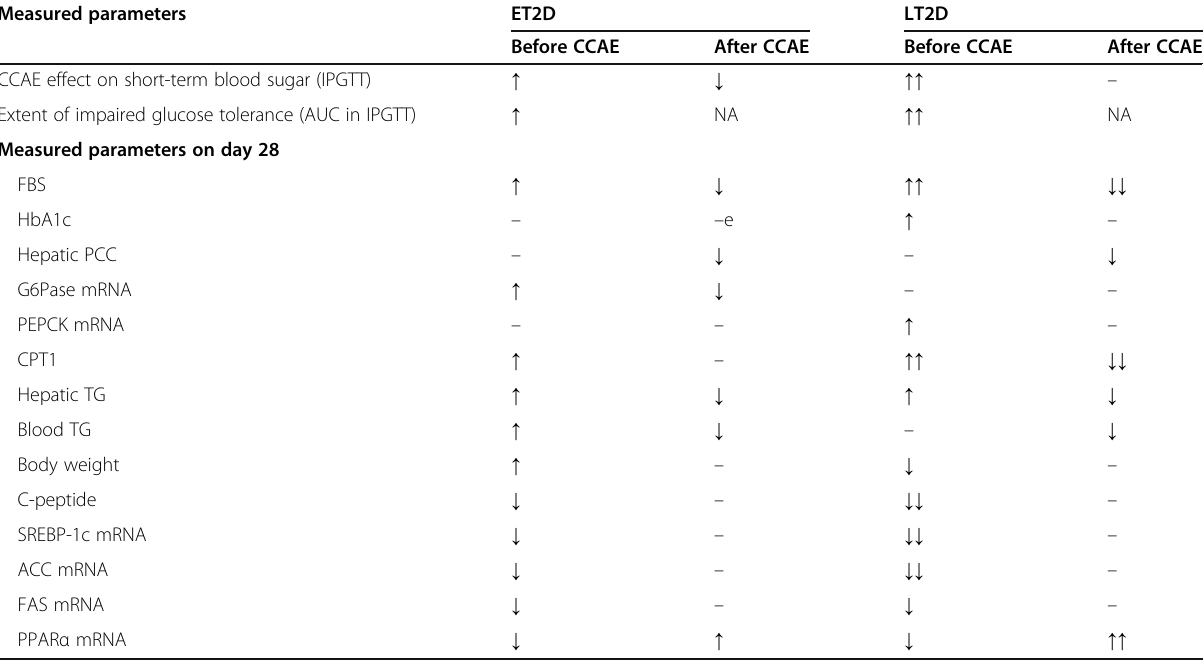
Before CCAE After CCAE